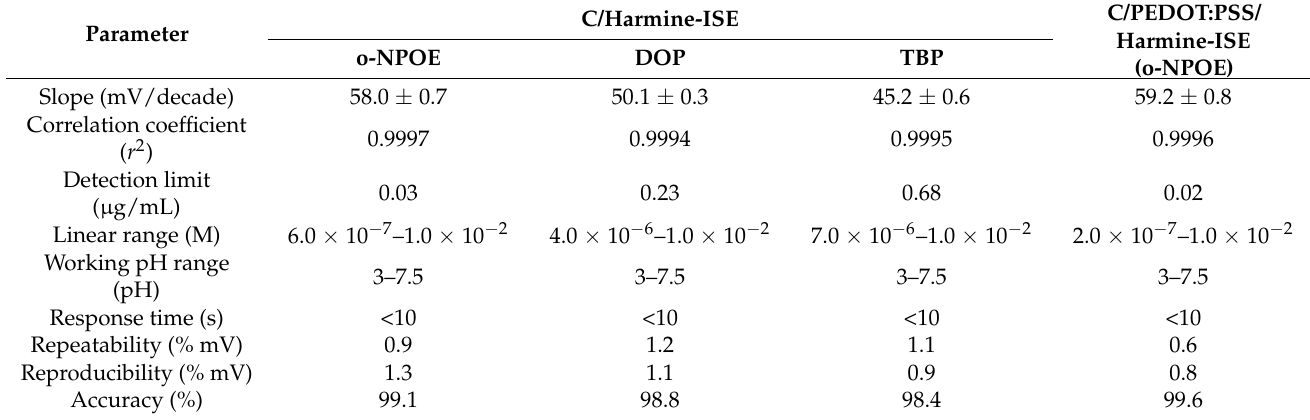
Figure 3. Effect of solvent mediator polarity on the potentiometric response of harmine membrane-based sensor. The selectivity coefficients of membrane sensors with different plasticizers were Table 1. Performance potentiometric characteristics of harmine ISEs. such as harmaline, strychnine, cinchonine, quinine, brucine, adrenaline and caffeine were